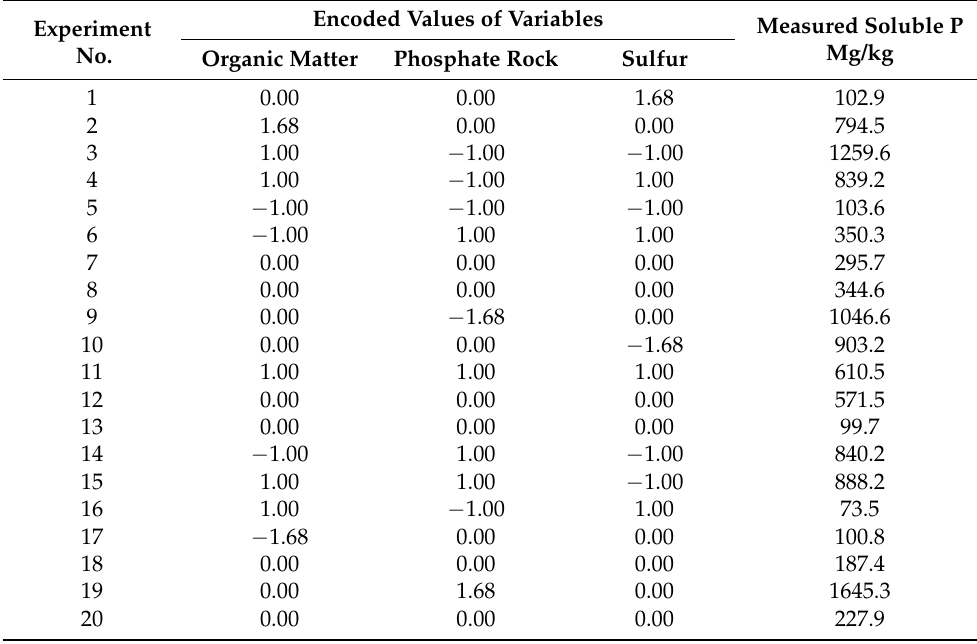
Table 2. The matrix of encoded values of variables in modeling the central composite design method. Encoded Values of Variables Measured Soluble P Experiment Mg/kgOrganic Matter Phosphate Rock No.